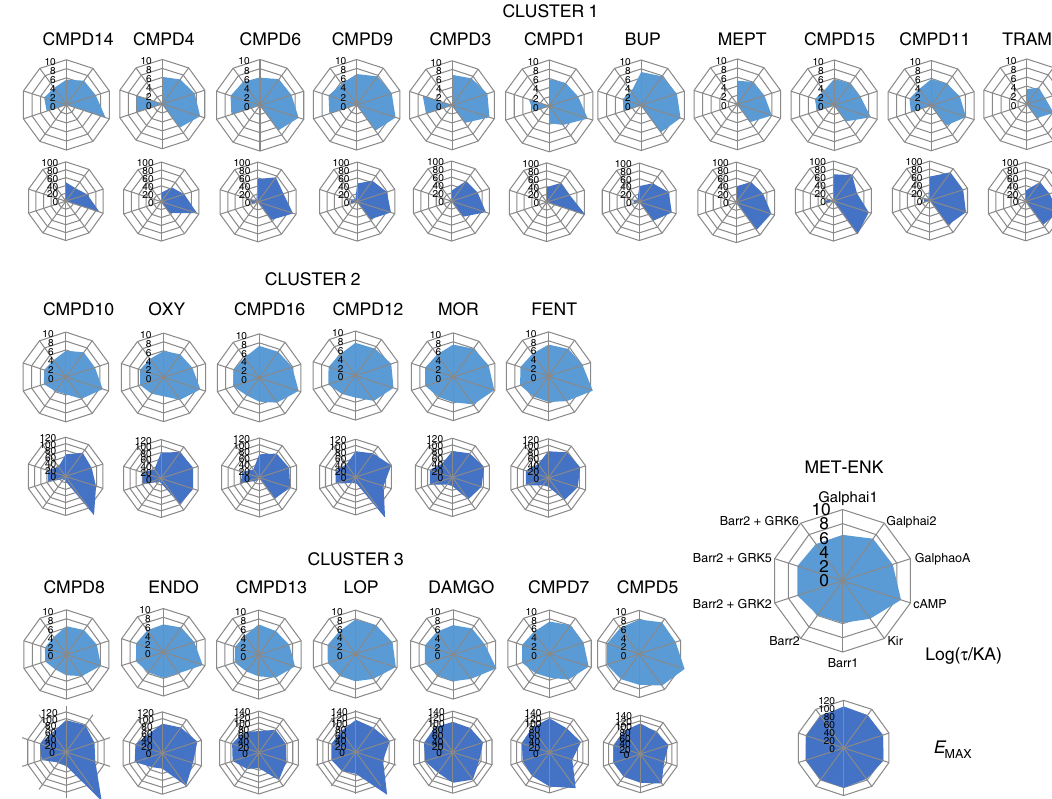
Fig. 4 Graphic representation of operational and logistic parameters for hMOR ligands populating different clusters. Operational transduction coef fi cients (Log( τ /KA)) and logistic E max values derived from concentration response curves generated by hMORs at ten different biosensors were represented as radial graphs. Each radius corresponds to the magnitude of Log( τ /KA) or E max values. Transduction coef fi cients are in logarithmic scale, E max values were normalized to maximal Met-ENK response, and are presented on linear scale. Source data provided in Supplementary Data